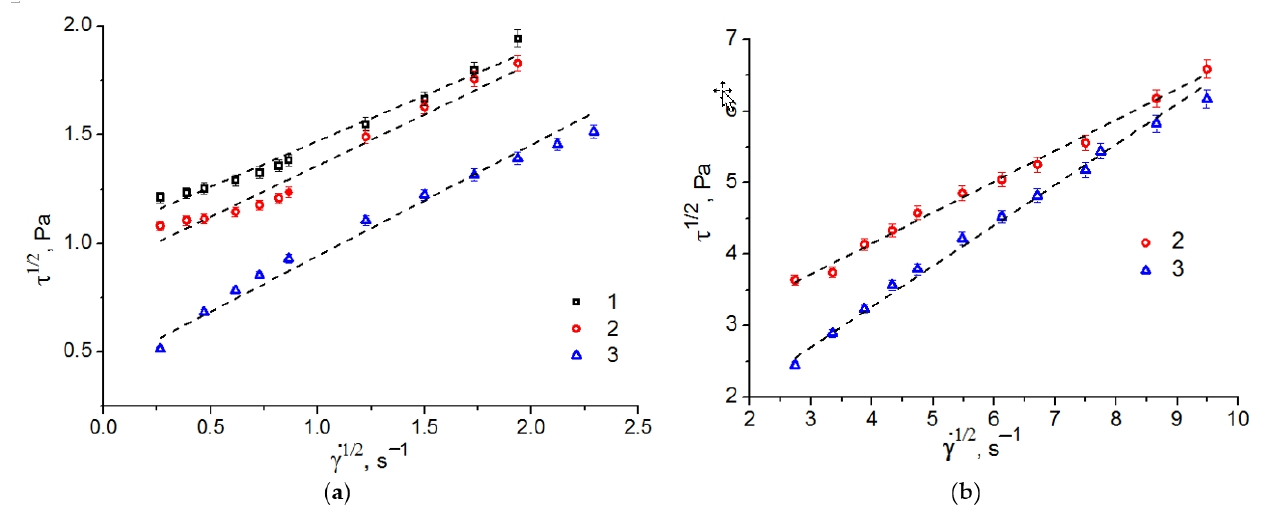
Figure 5. Flow curves in square root coordinates at low ( a ) and high ( b ) shear rates of the systems: 1. Chit/LA 15/85 wt. %, 2. C 12 EO 4 /(Chit:LA) 50/50 wt. %, 3. Chit/LA 5/95 wt. %. Dashed lines (–) are plotted according to the Casson